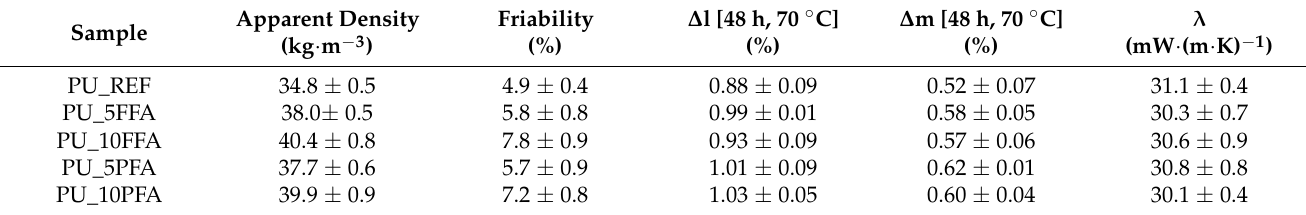
Table 2. Physical properties and friability of the RPUF samples.